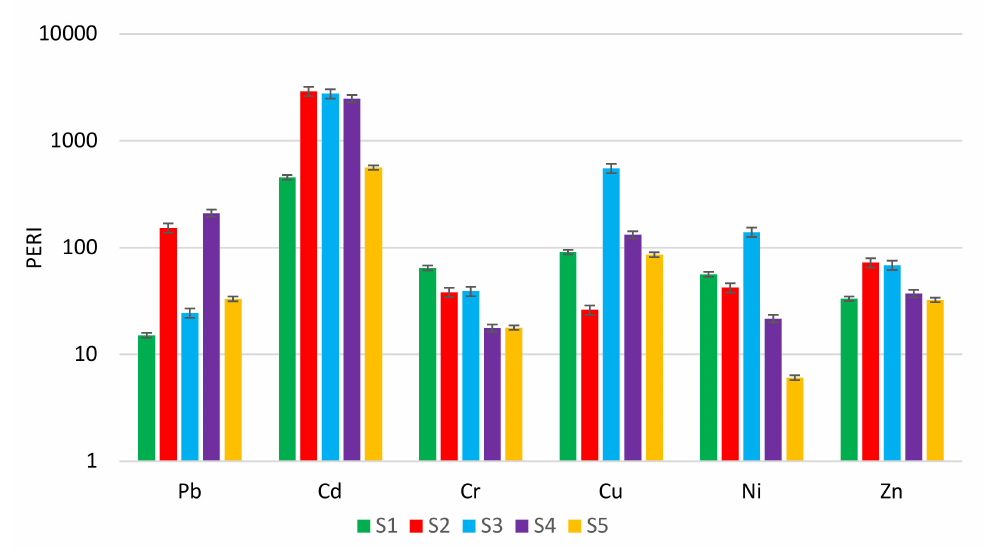
Figure 4. PERI of HMs in